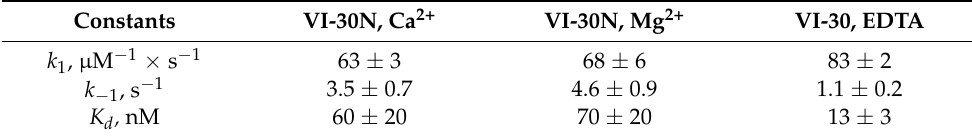
Table 2. Parameters of the Nt.BspD6I interaction with DNA duplex VI-30 or VI-30N .